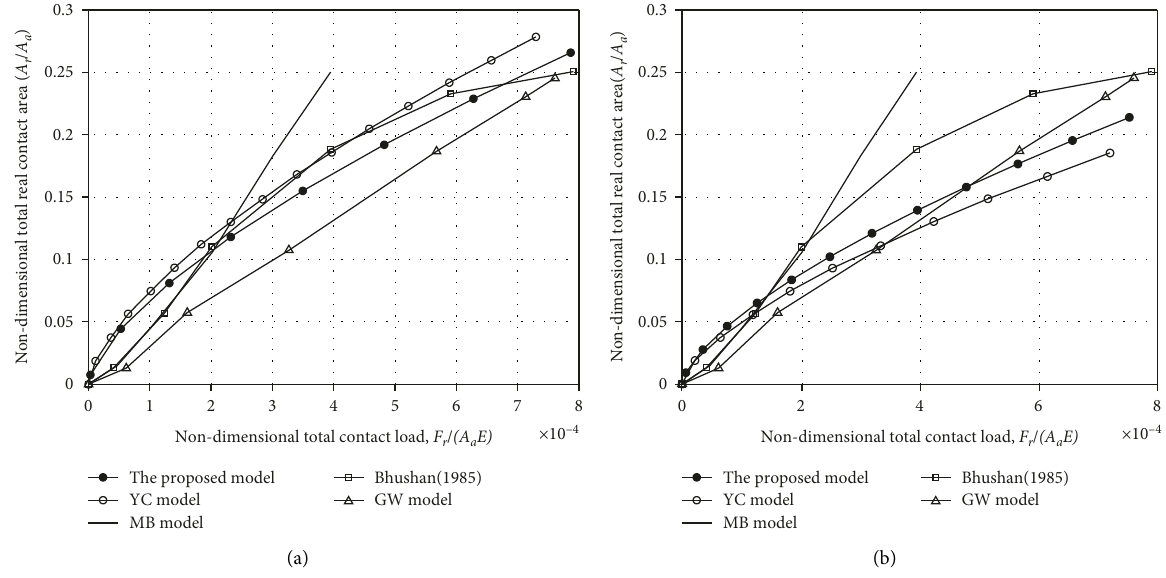
Figure 14: Comparison of the proposed model and other contact models with experiment data. (a) n � 70 , n � (b) n min max